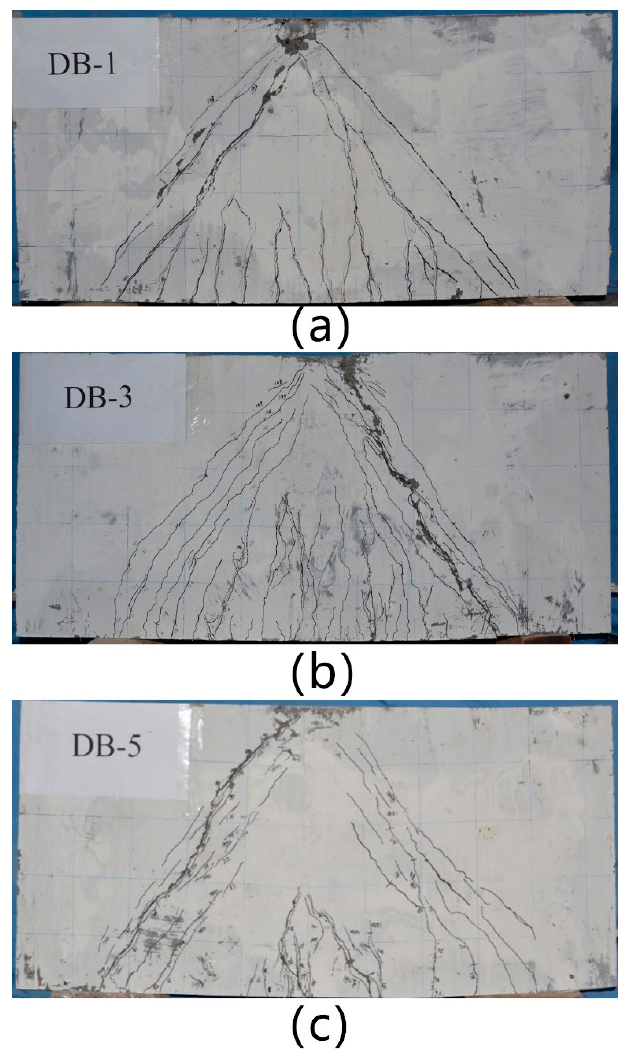
Figure 8. Cracks of specimens. ( a ) DB-1; ( b ) DB-2; ( c ) DB-3.